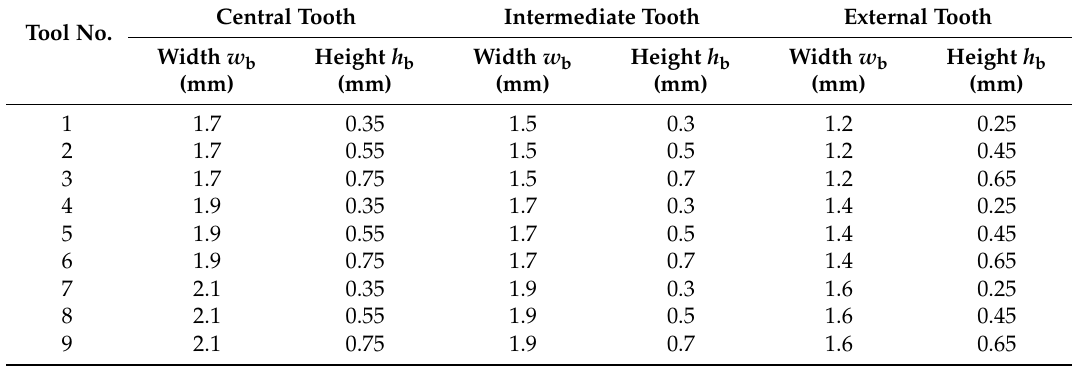
Table 1. Physical characteristic parameters of SA508-3 steel.